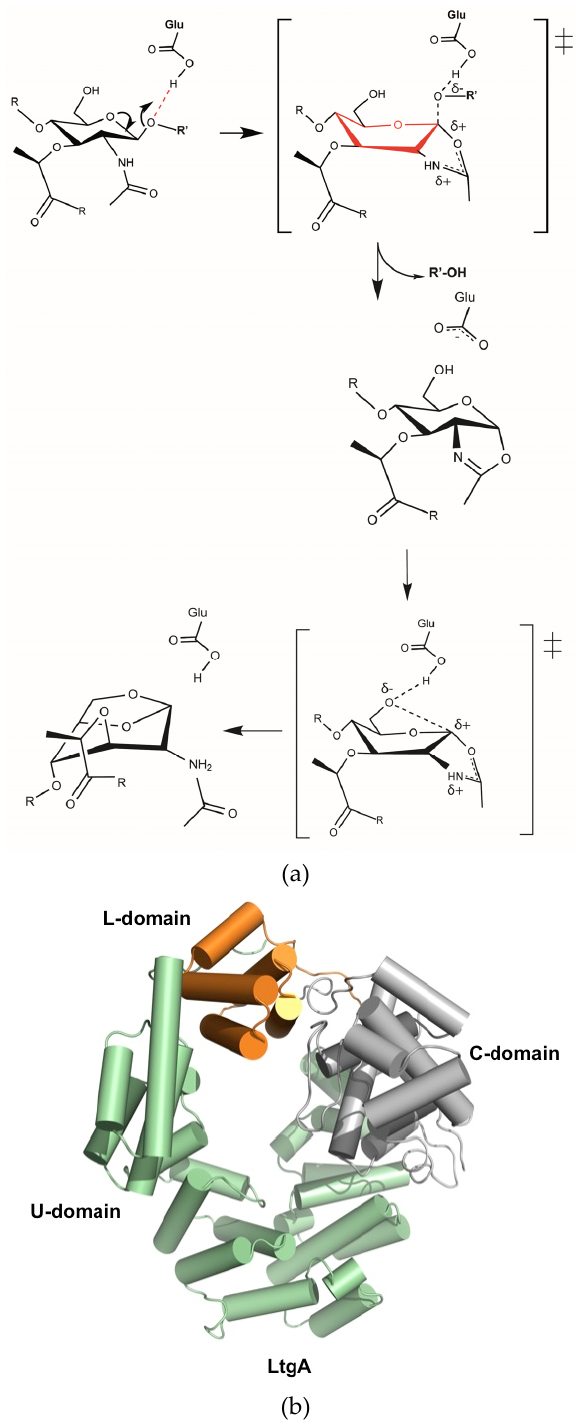
Figure 1. ( a ) Proposed catalytic mechanism of lytic transglycosylases (Lts). Lts use a single catalytic glutamate or aspartate in a simple acid and then base catalysis. In the absence of a second catalytic residue in the active site, these enzymes proceed via anachimeric assistance of the N-acetylmuramic acid (MurNAc) 2-acetamido group and formation of the oxazolinium ion intermediate [31]; ( b ) Overall structure of LtgA. LtgA has three domains: U (green), L (orange) and C (grey). Structure is displayed in a front view. The helices are represented as